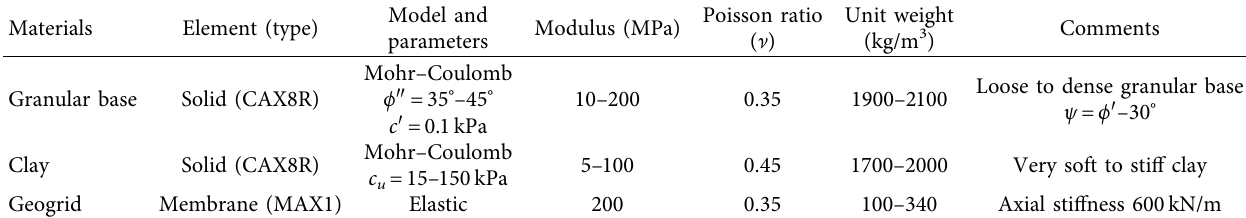
Table 2: Material properties for FEM analysis of square footings.